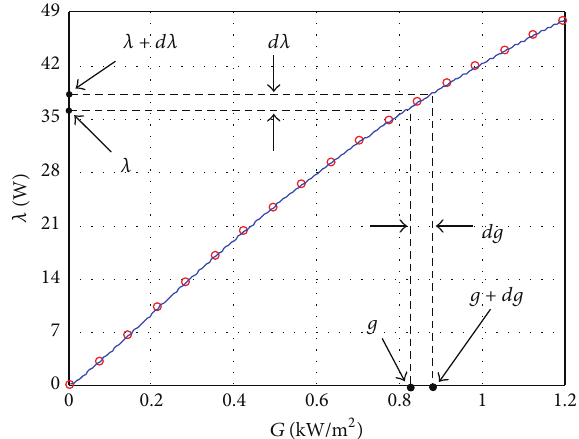
Figure 3: MPO of the module 𝜆 against the irradiance level 𝐺 , obtained by a numerical method (scattered circles) and by an approximate function